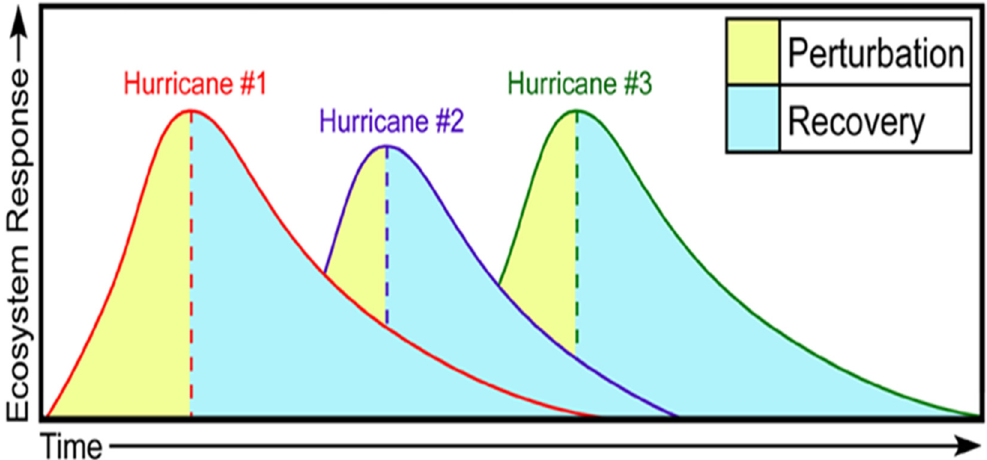
Figure 11. Conceptual diagram illustrating recovery of shallow lakes from hurricanes relative to the frequency of recurrence of events.